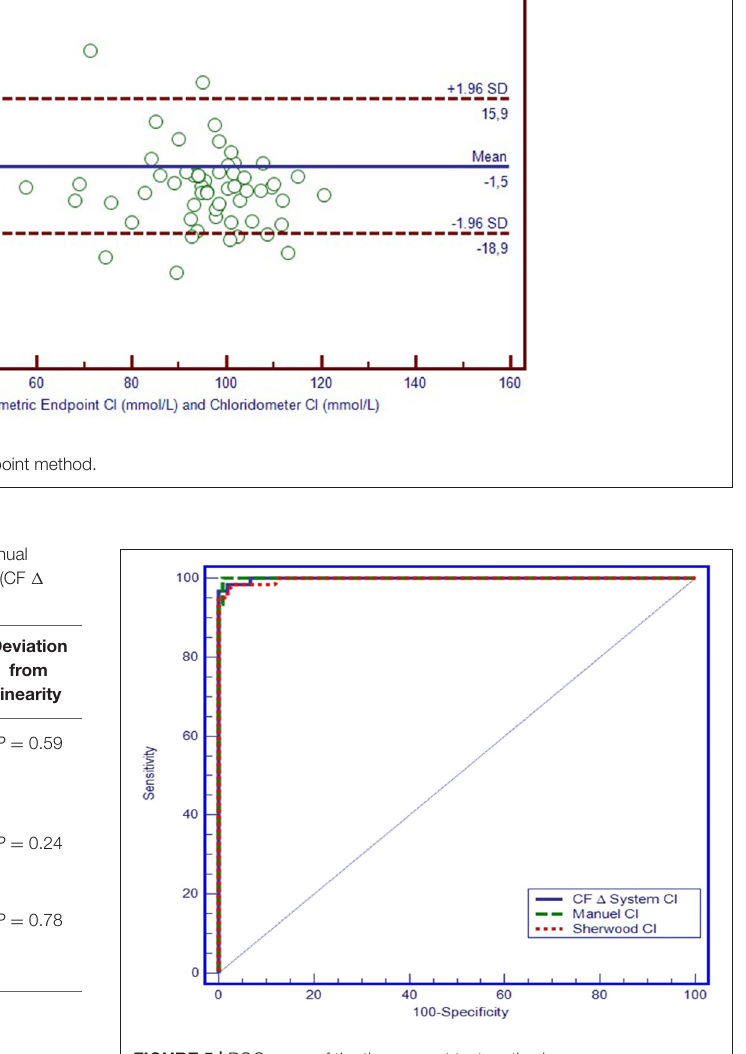
FIGURE 5 | ROC curve of the three sweat test